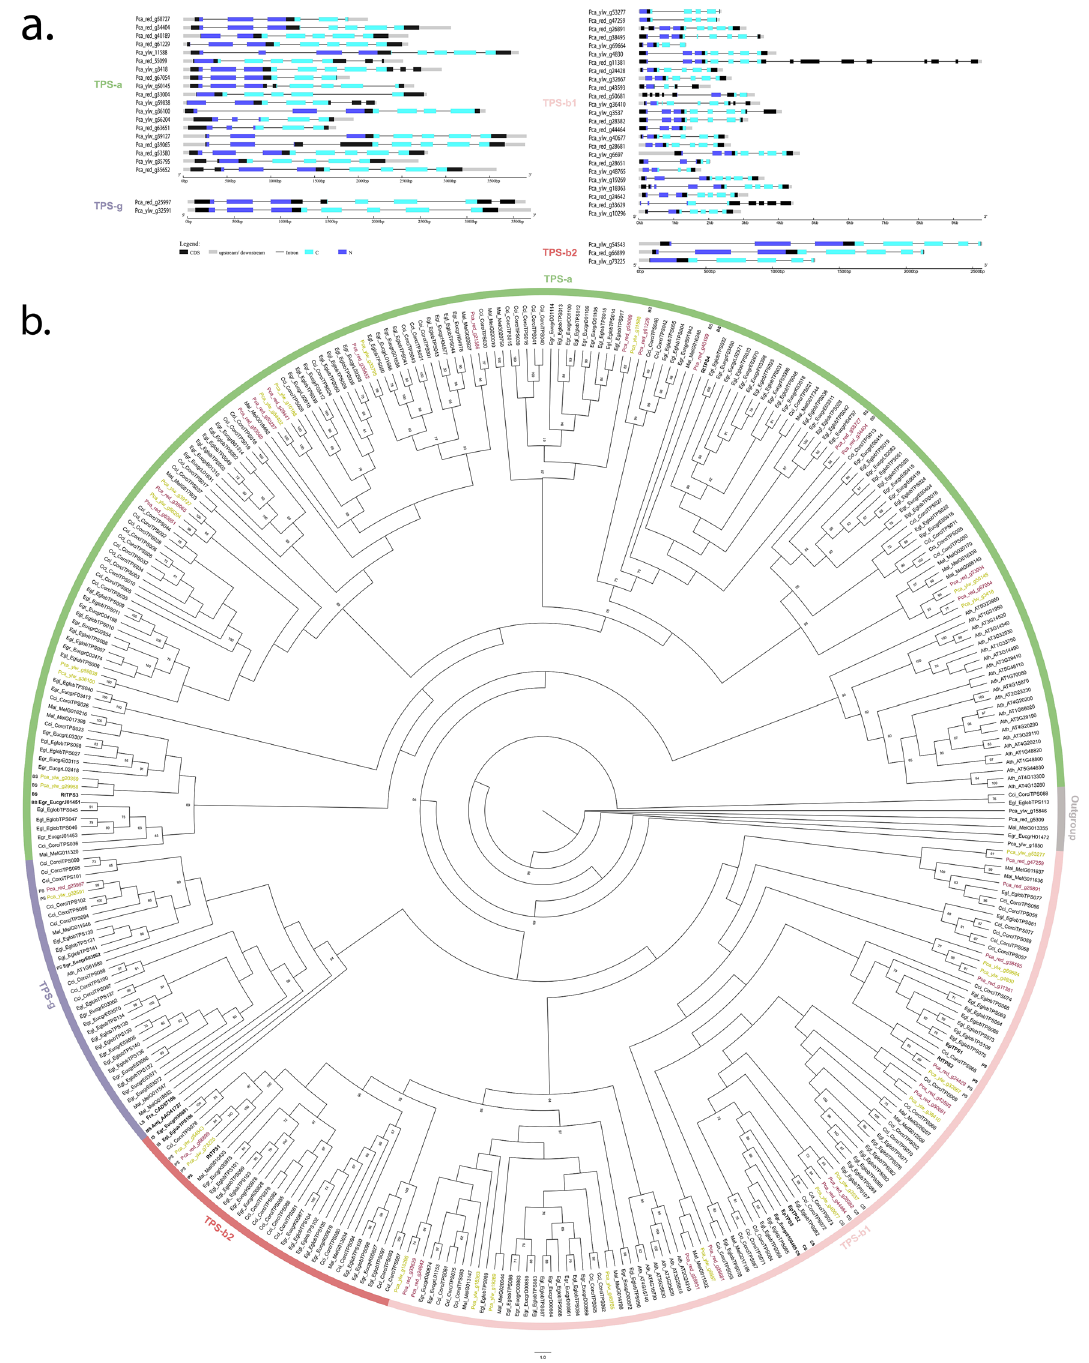
Figure 1. Phylogeny and gene structure of TPS from secondary metabolism. ( a ) Conserved domains in TPS genes and their consensus sequences from P. cattleyanum. ( b ) Phylogenetic tree of the Tps-a, Tps-b and Tps-g subfamilies from P. cattleyanum genome and characterized representative TPS from other Myrtaceae species. This tree was constructed through maximum likelihood analysis comparing the red and yellow morphotypes (Pca_red and Pca_ylw), C. citriodora subsp. variegata (Cci), E. grandis (Egr), E. globulus (Egl), M. alternifolia (Mal) and A. thaliana (Ath). Functional characterized terpene synthases are written in bold. Bootstrap values supported by < 60% are noted by number. A few species from TPS-c clade were used as the